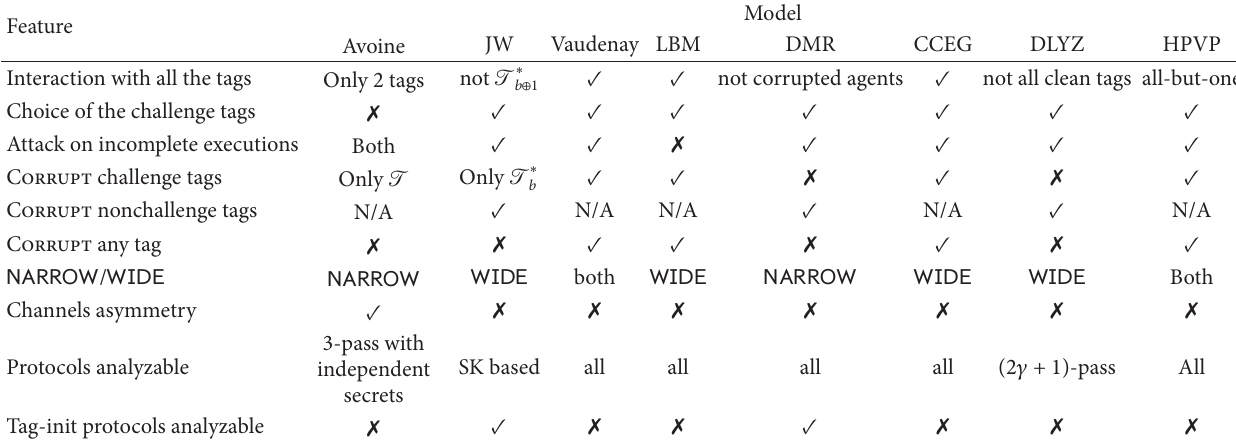
Interaction with all the